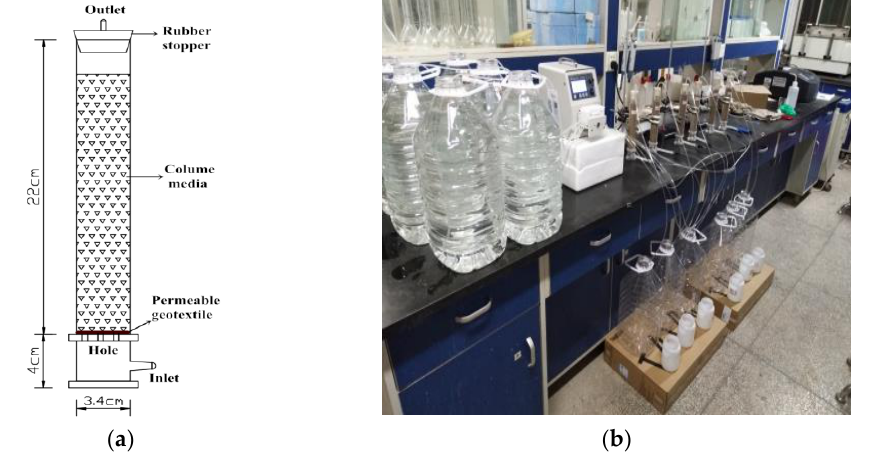
Figure 1. Mini-column dimensions ( a ) and running diagram ( b ).